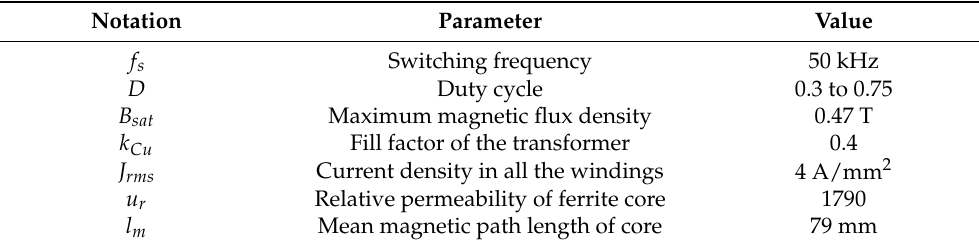
Table 5. Design input